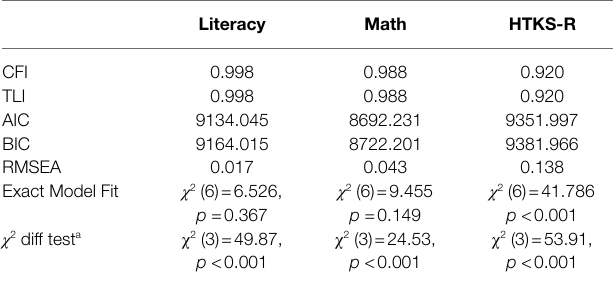
TABLE 4 | Model fit statistics for linear growth models of individual variables. Literacy